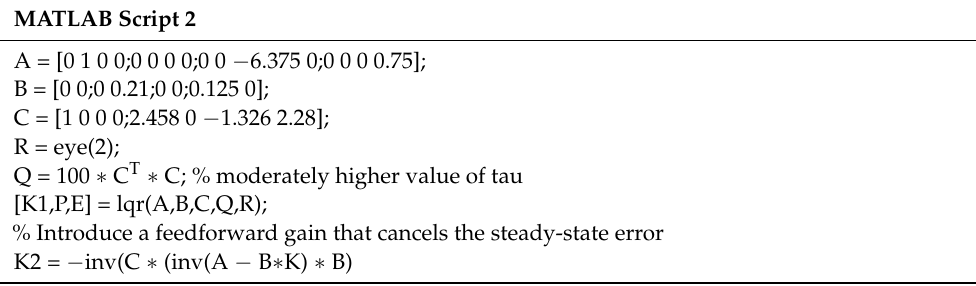
Figure 5. Corrected output response with 𝐸 (cid:3007)(cid:3005) = 1 , 𝑃 (cid:3040) = 1 .